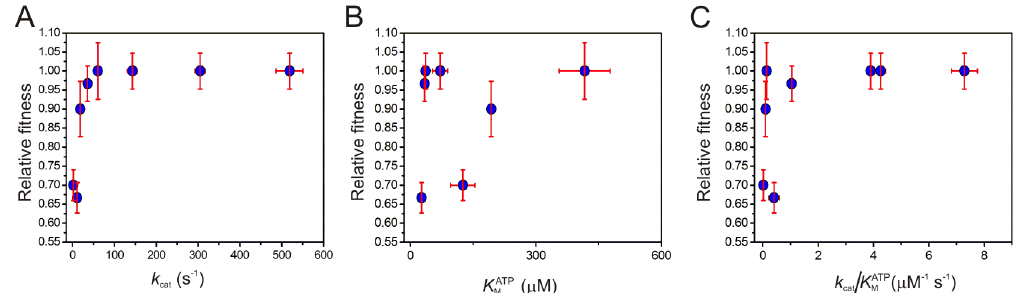
Fig 8. Dependencies of relative fitness on Adk catalytic parameters k cat , K ATP M and k cat / K ATP M . (A) Relative fi tness plotted versus k cat . (B) Relative fi tness plotted versus the Michaelis constant ( K M ). (C) Relative fi tness plotted versus the speci fi city constant ( k cat / K ATP M ). Cells were cultivated for growth rate measurements at 20°C. Catalytic parameters ( k cat and K ATP M ) were obtained from a coupled ATPase assay [33]. Error bars for growth rate constants indicate standard deviations obtained from three independent biological replicates. Error bars for Adk catalytic parameters k K ATP cat and M indicate standard deviations of three technical replicates.